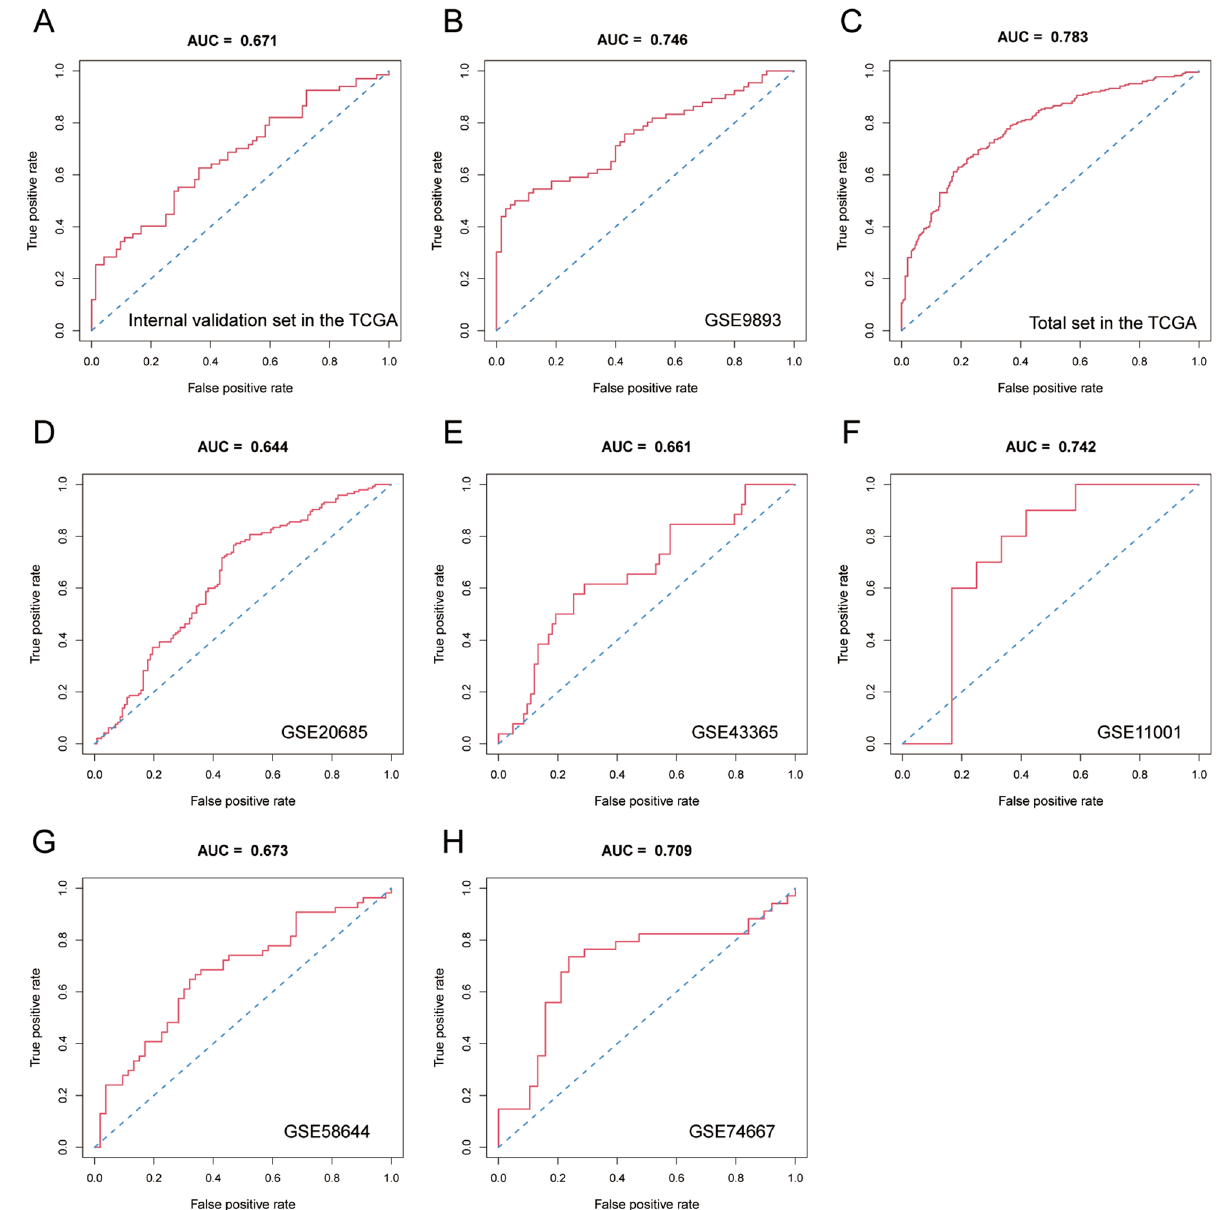
Figure 3. Discrimination ability of the model in the internal verification and external verification cohorts. ( A – C ) ROC curve analysis of the model in the internal validation cohort in the TCGA and GSE9893 and the total set in the TCGA; ( D – H ) ROC curve analysis of the model in the external verification cohorts, such as GSE20685, GSE43365, GSE11001, GSE58644 and ated the correlation between the risk of ALNM in T1–2 BC patients and the immune infiltration level with the ImmunCellAI online resource. The results showed that the risk of ALNM was related to the infiltration of tumor immune cells such as macrophages, T helper type 1 cells (Th1), T helper type 17 cells (Th17), and cytotoxic T cells (CTLs) (Fig. 6B). We calculated the 22 subpopulations of immune cells in 685 BC patients (according to the previous inclusion and exclusion criteria of the TCGA database, patients were re-incorporated without restricting the expression of ER,PR and HER2) by using the CIBERSORT algorithm and investigated the differences between tissues with different N stages. Surprisingly, the lymph node stage was correlated with the infiltration of M2 macrophages ( P -value < 0.05) (Fig. 6C). Based on the TIMER2.0 database, we further explored the functions of the 11 genes in the model, all of which were associated with the infiltration of M2 macrophages (Fig. 6D).